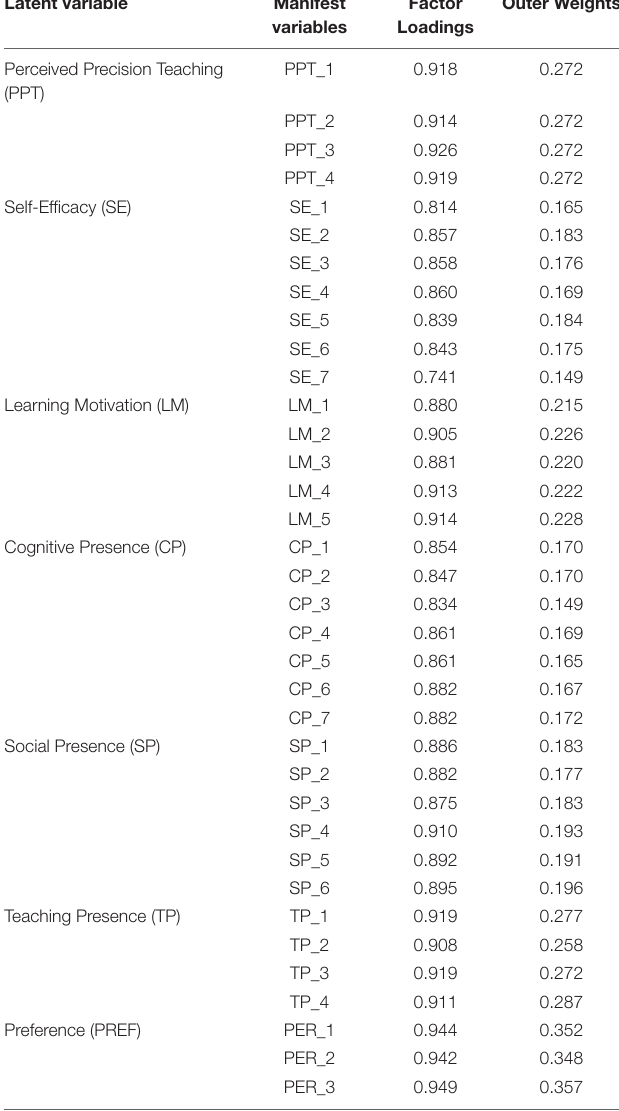
TABLE 4 | Fornell and Larcker (1981)